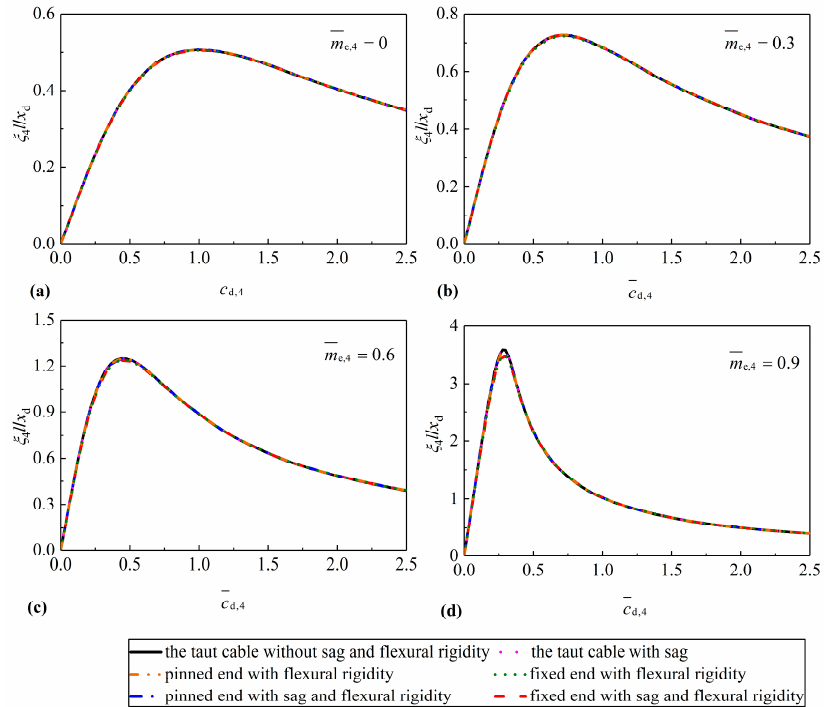
Figure 7. The fourth supplemental modal damping ratio of the short cable versus damping coefficient for various inertial masses: ( a ) m e,4 = 0; ( b ) m e,4 = 0.3; ( c ) m e,4 = 0.6; ( d ) m e,4 =